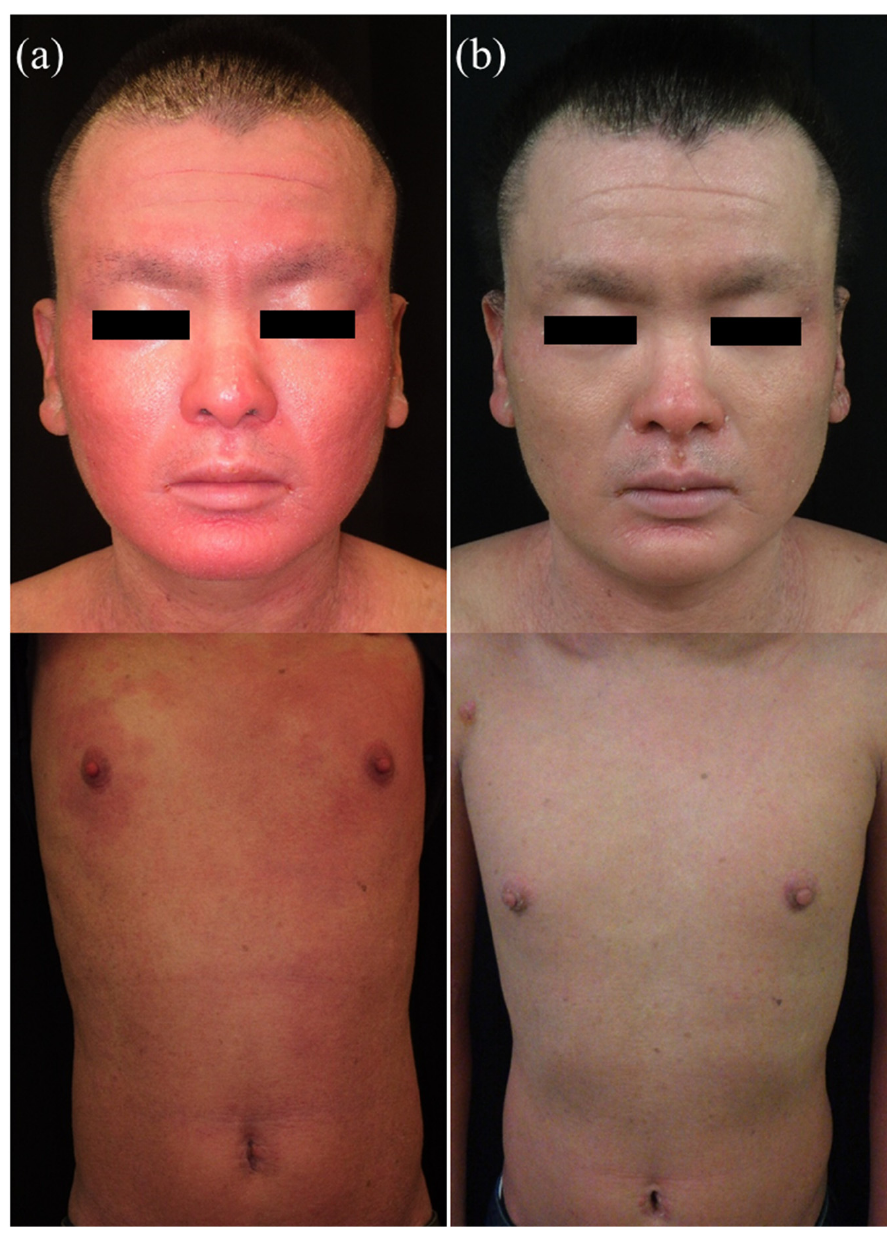
Figure 3. Clinical images ( a ) before and ( b ) one year after the treatment. The treatment was effective in reducing redness and erythema on the face and trunk.